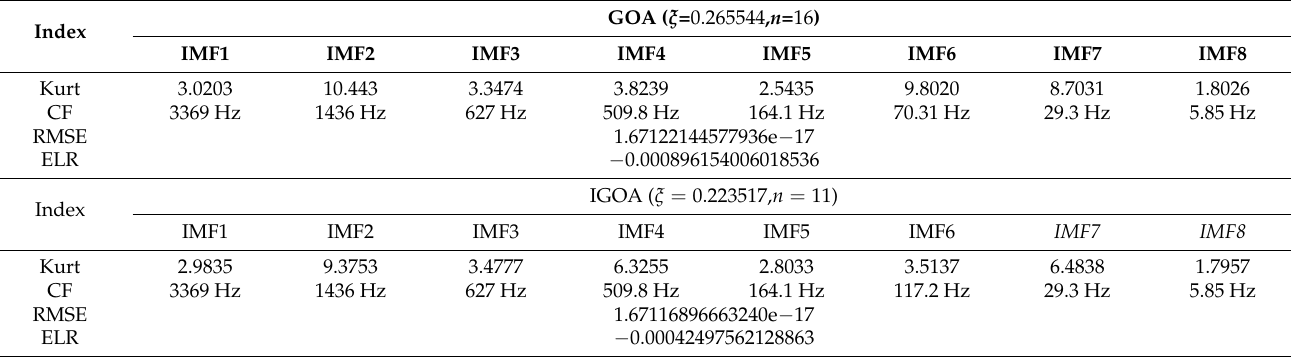
Table 11. Fault characteristic frequency (unit: Hz).